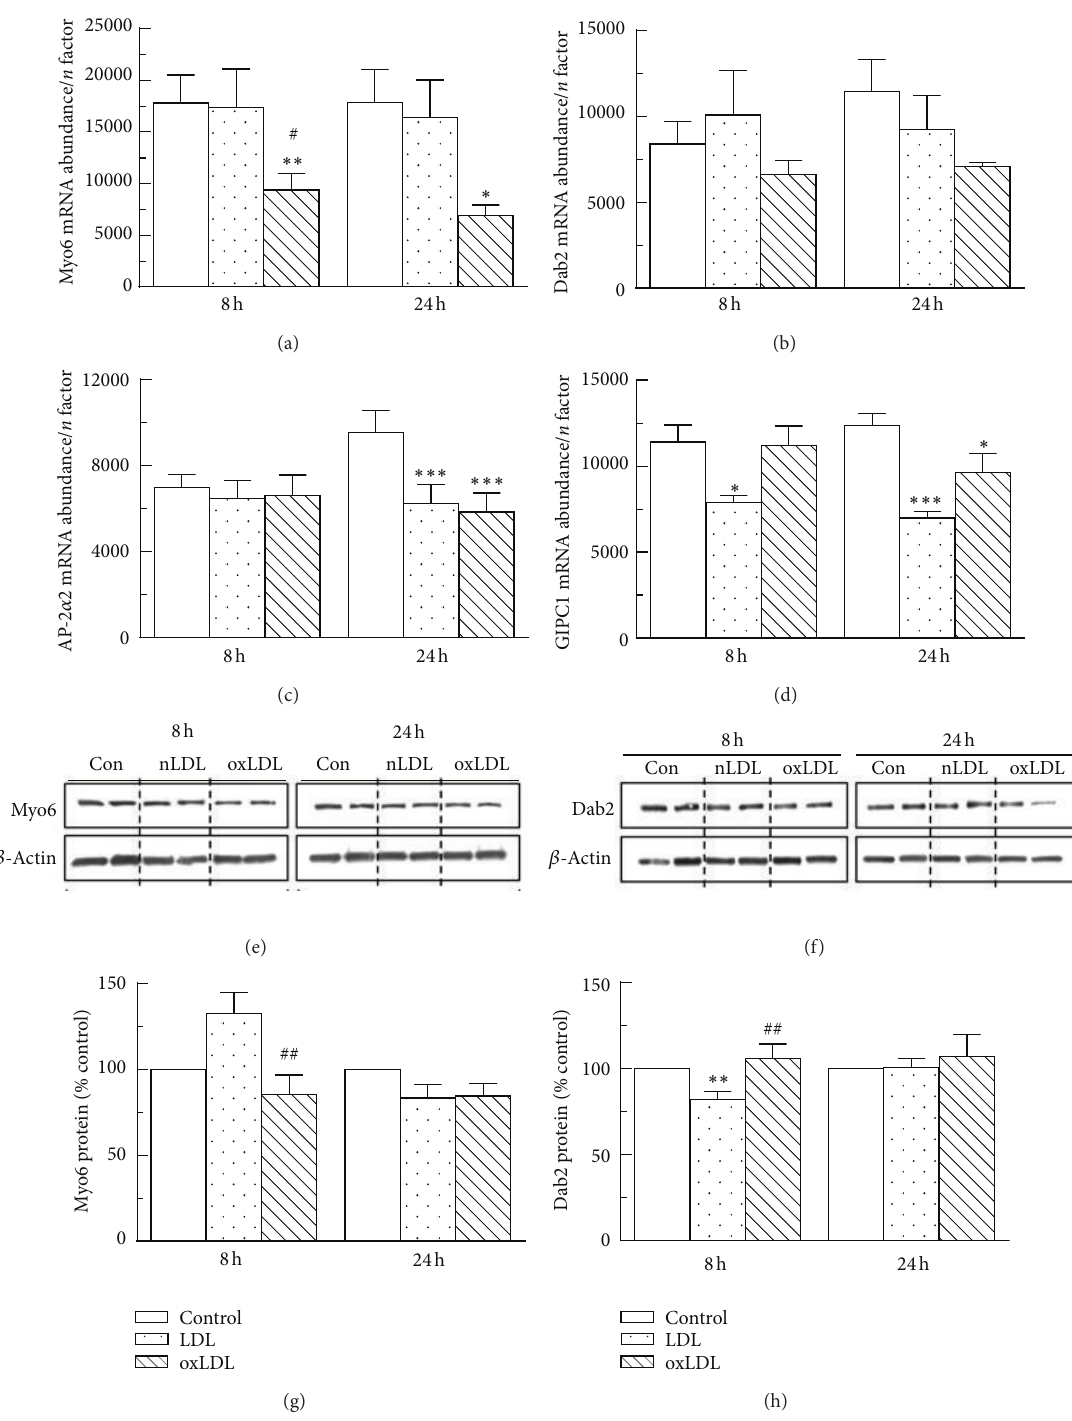
Figure 8: Effects of LDL and oxLDL on expression of mRNA and protein for Myo6 and related proteins in THP-1 macrophages. THP-1 cells were incubated with nLDL or oxLDL (50 𝜇 g protein/mL) or an equal volume of PBS (control) for 8h or 24 h, and total RNA or protein was isolated. The abundance of transcripts for (a) Myo6, (b) Dab2, (c) AP-2 𝛼 2, and (d) GIPC1 was determined by qPCR (quantified using a standard curve and normalised using geNorm), and the expression of protein for (e) Myo6 and (f) Dab2 was assessed by immunoblotting using 𝛽 -actin as the housekeeping gene (Con, control). Band density was quantified using Quantity One software (Biorad), and results for (g) Myo6 and (h) Dab2 are expressed as % control value. Data shown ((a)–(d), g, h) are the mean from 4 separate experiments and error bars show the SEM. Significance limits ∗ 𝑃 < 0.05 , ∗∗ 𝑃 < 0.01 , ∗∗∗ 𝑃 < 0.001 versus control; # 𝑃 < 0.05 , ## 𝑃 < 0.01 versus nLDL (one-way